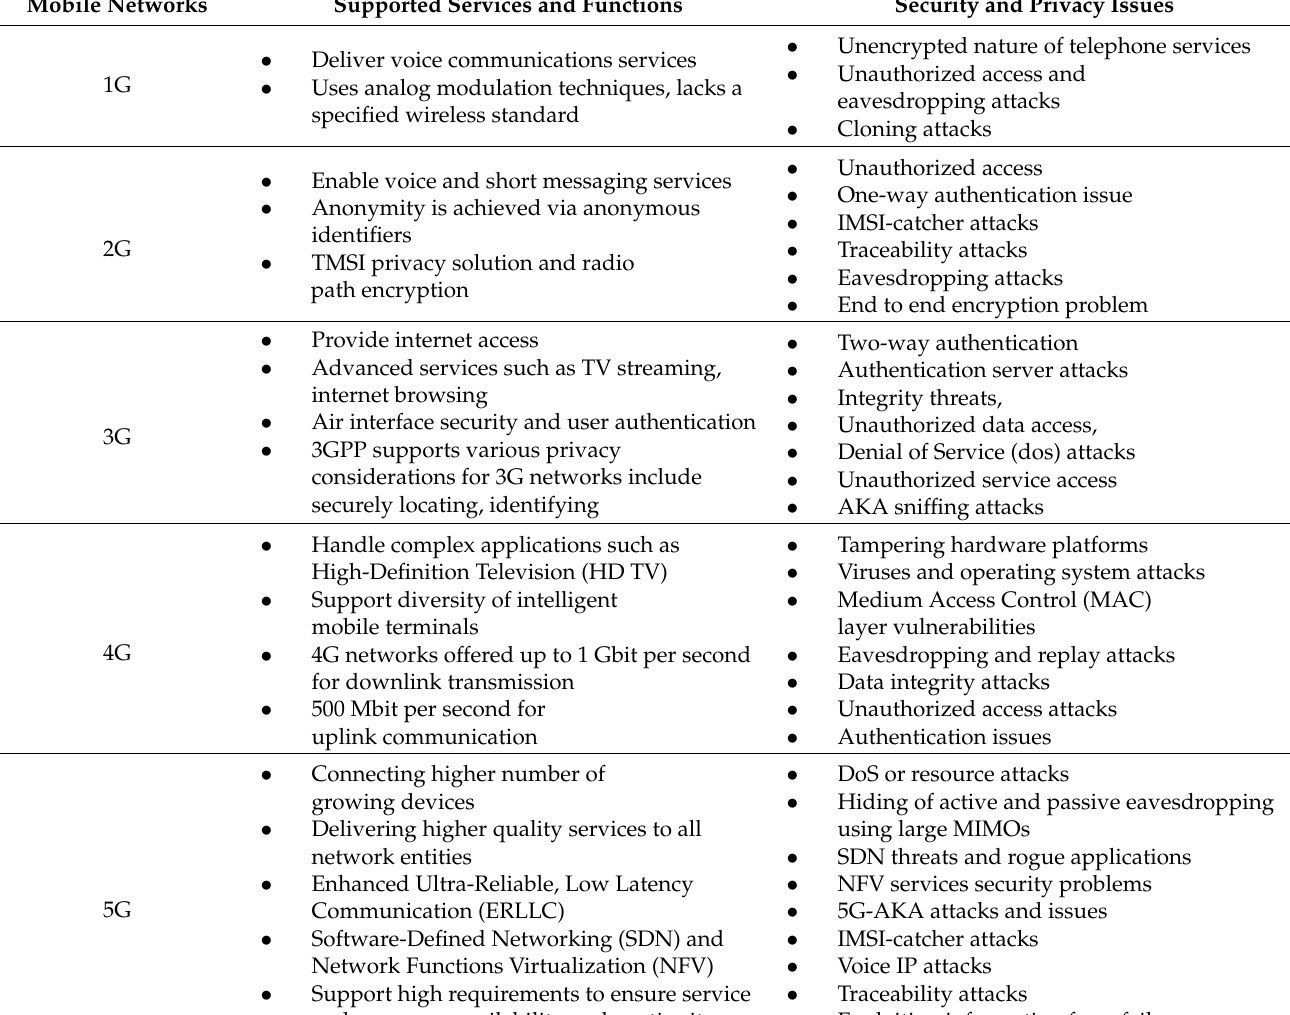
Table 1. Security and privacy issues in earlier mobile